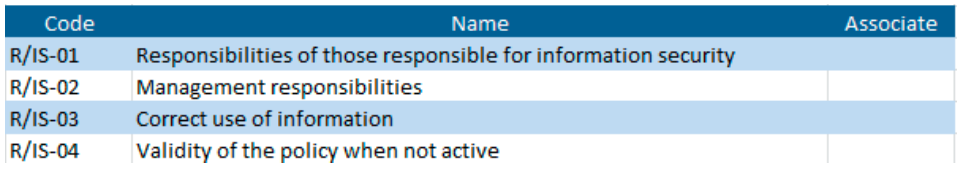
Figure 10. A3.1—Screenshot of the security culture test.